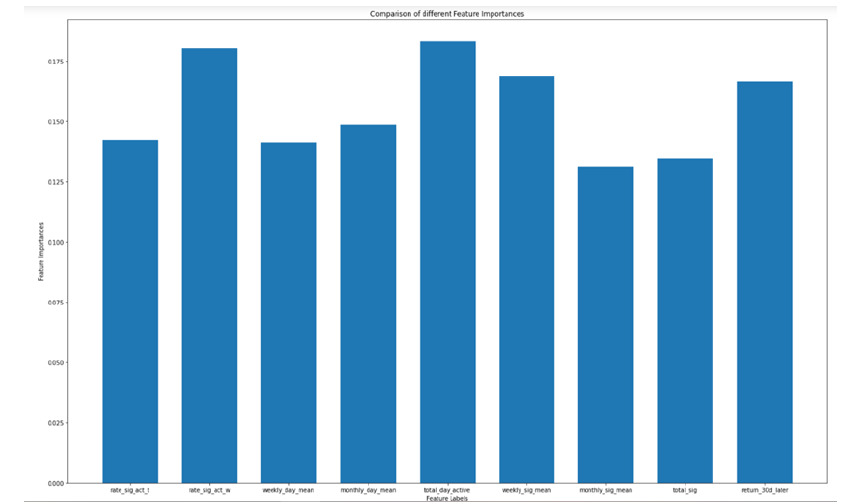
Figure 4. Factors of importance in cluster